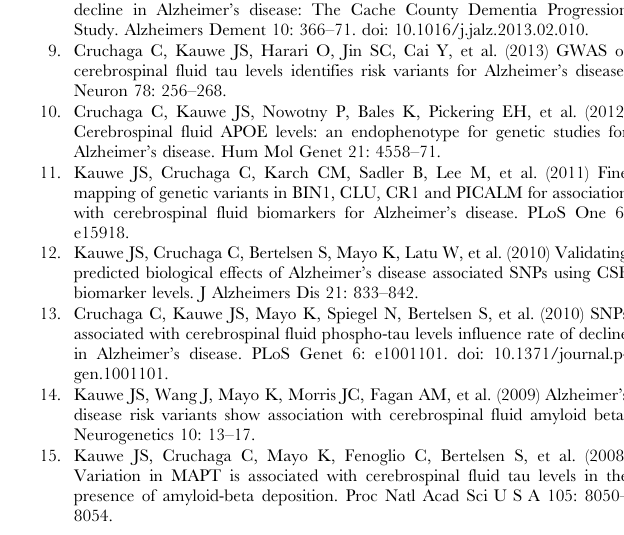
Table S4 Multiphen results. For each SNP and phenotype the p- value from ADNI, Knight ADRC, metaanalysis results are shown. Table S5 Analyte names. The name of each analyte in the Human Discovery MAP documentation, official protein name and official structural gene name and resuls of the PubMed search for previous links to Alzheimer’s disease are